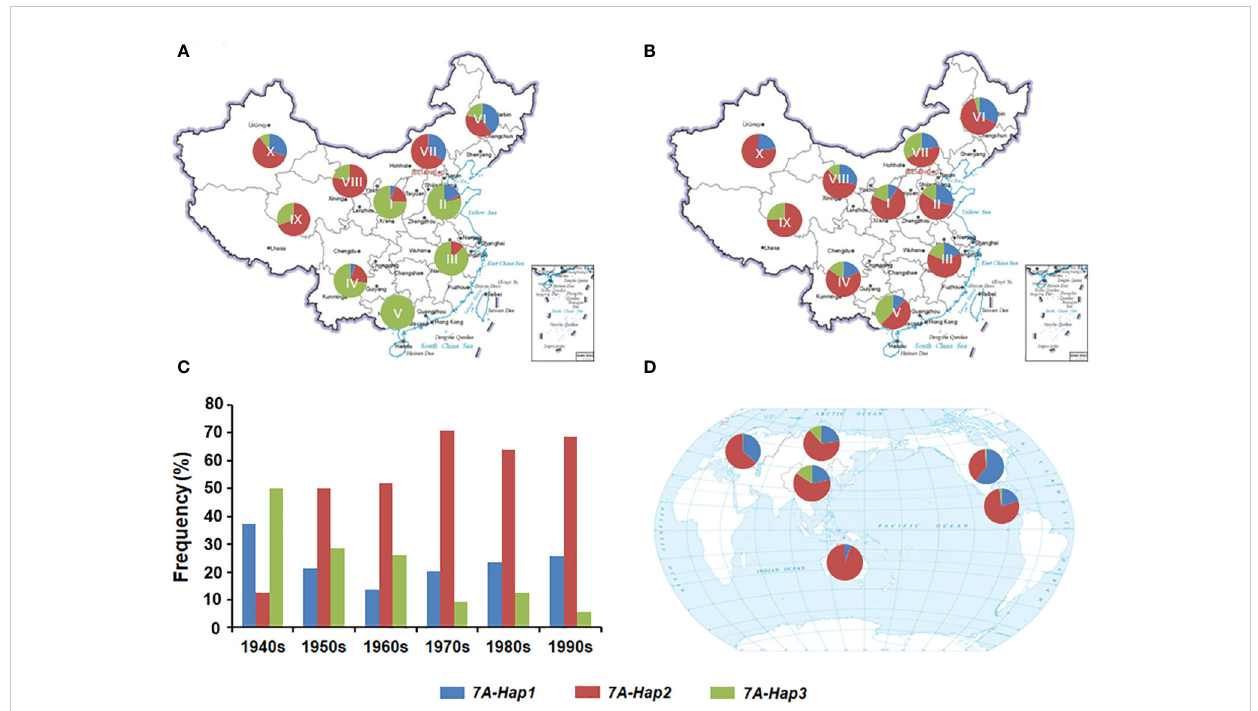
FIGURE 7 Geographic distribution and frequency change of TaSPL14-7A haplotypes. (A) Distribution of TaSPL14-7A haplotypes in Chinese landraces from ten agro-ecological zones (I, northern winter wheat region; II, Yellow and Huai River valley winter wheat region; III, low and middle Yangtze River valley winter wheat region; IV, southwestern winter wheat region; V, southern winter wheat region; VI, northeastern spring wheat region; VII, northern spring wheat region; VIII, northwestern spring wheat region; IX, Qinghai-Tibet spring-winter wheat region; X, Xinjiang winter-spring wheat region). (B) Distribution of TaSPL14-7A haplotypes in modern Chinese cultivars from ten agro-ecological zones. (C) Frequency changes of TaSPL14-7A haplotypes in different Chinese wheat breeding periods (from the 1940s to the 1990s). (D) Distribution of TaSPL14-7A haplotypes in major global wheat regions including China, North America, Europe, former USSR, CIMMYT, and